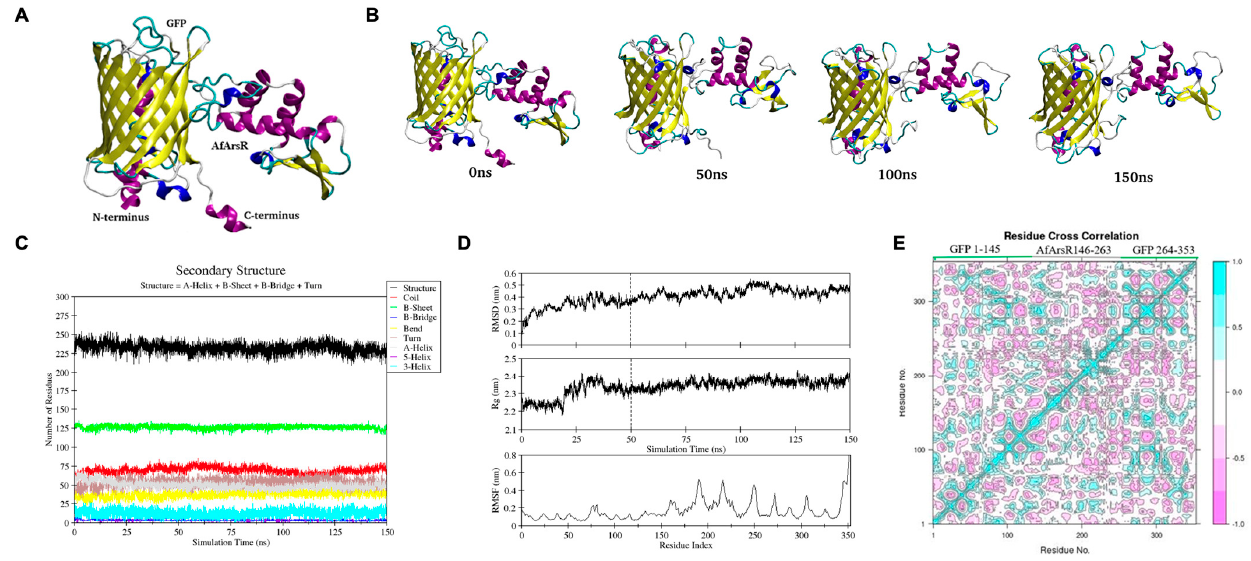
Figure 5. ( A ) Structure of GEAR G1 predicted by Robetta. ( B ) Snapshots of structure of GEAR-G1 at different time scales of MD simulation. Yellow, purple, blue, and cyan/white colors depict various secondary structure elements such as β -sheets, ɑ -helix, short ɑ -helices, and coil/turns, respectively. ( C ) Dictionary of Secondary Structure of GEAR-G1 protein (DSSP), as obtained from 150ns of MD simulation. ( D ) RMSD, Rg, and RMSF plots as calculated from the ɑ -carbons of the GEAR-G1 protein. The RMSF plot has been generated for the last 100 ns of the trajectory. Residues 146–263 correspond to AfArsR, and residues 1–145 and 264–353 correspond to GFP. ( E ) Dynamic cross correlation matrix map of the trajectory for GEAR-G1 protein complex. The value ranges from +1 (cyan color) to − 1 (purple color). Positive values represent positive inter-residual correlation, while negative values represent negative inter-residual correlation. The map depicts that both a positive and negative inter-residual correlation exists in the atoms of GEAR-G1 protein, which is essential for its function.